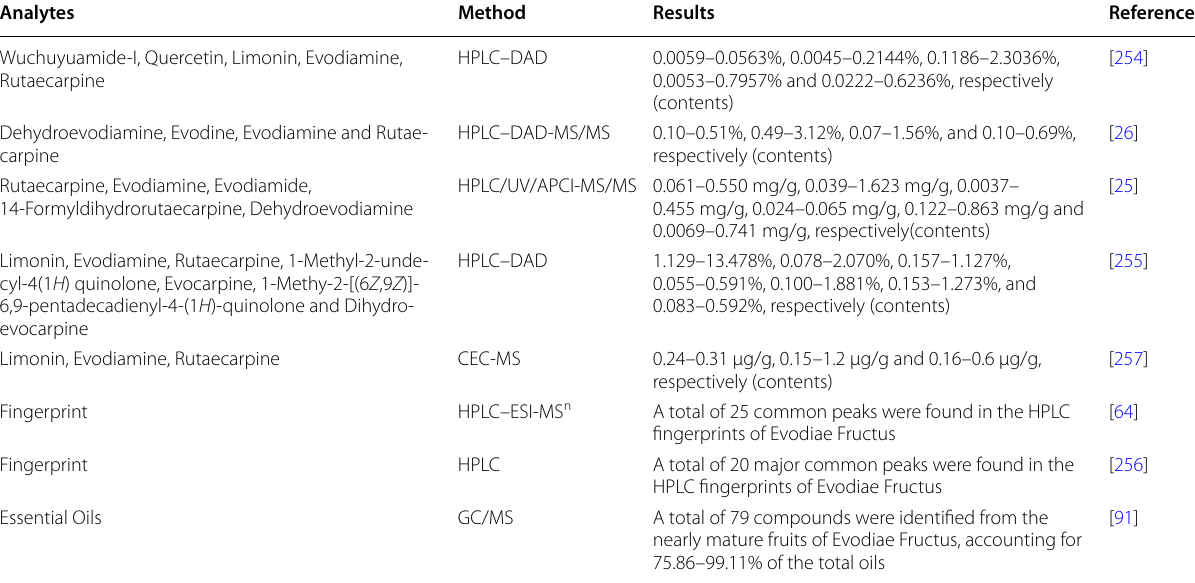
Table 6 Quantitative analysis for the quality control of Euodiae Fructus Analytes